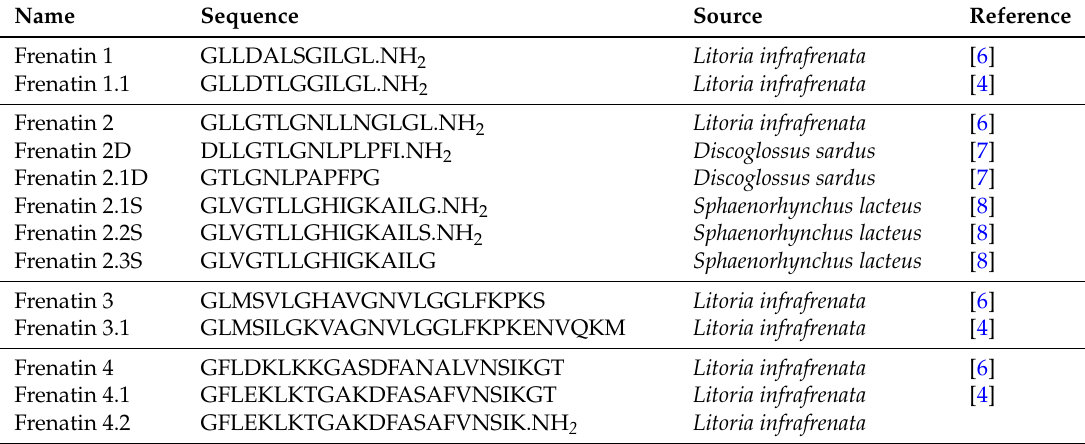
Table 3. Known frenatins, their sequences and